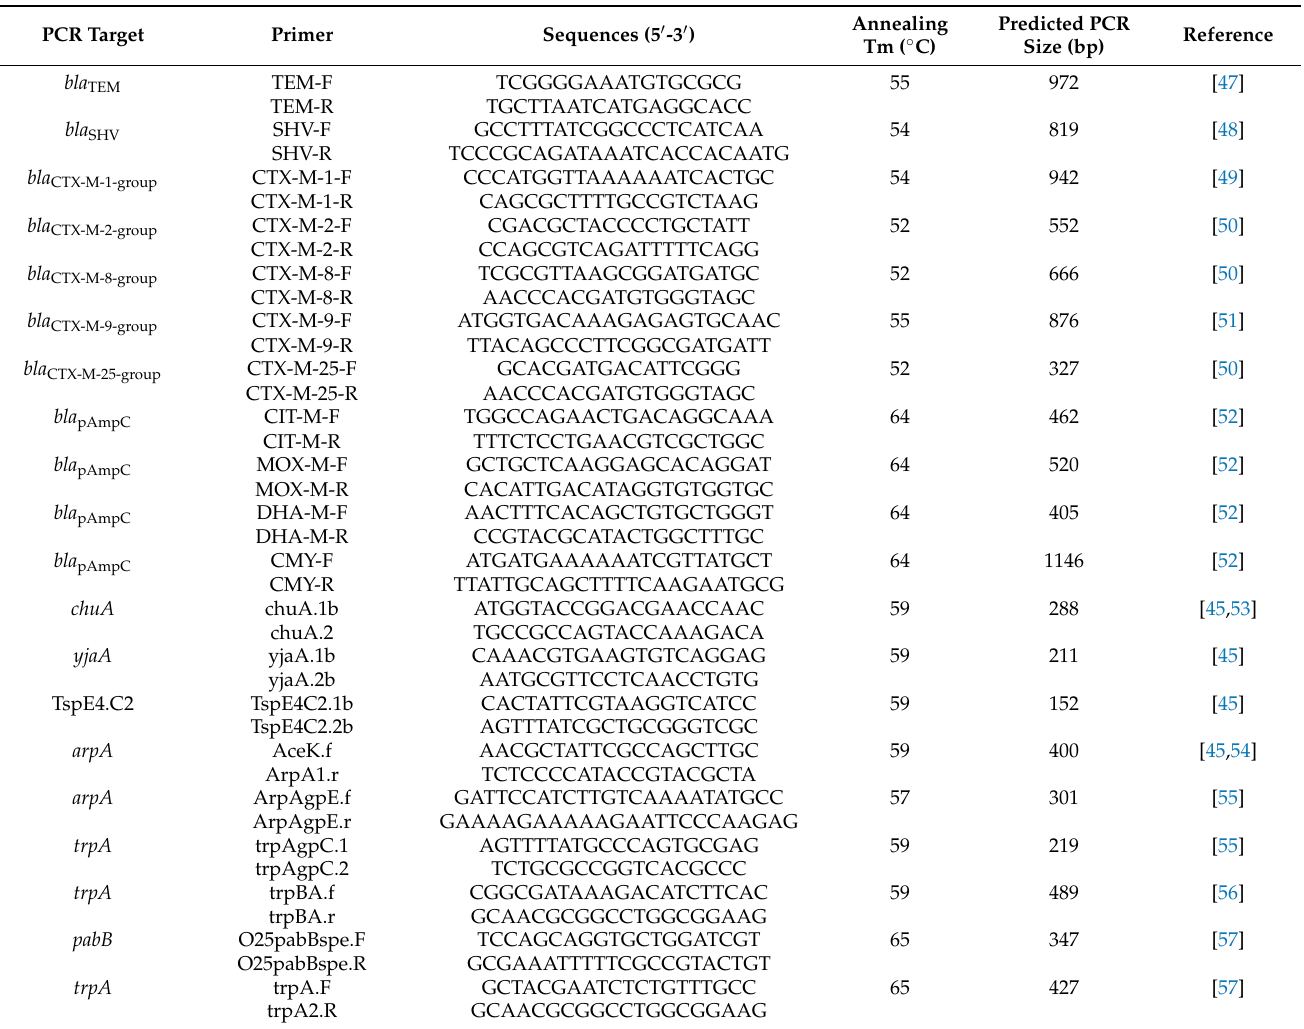
Table 3. Sequences of primers used in this